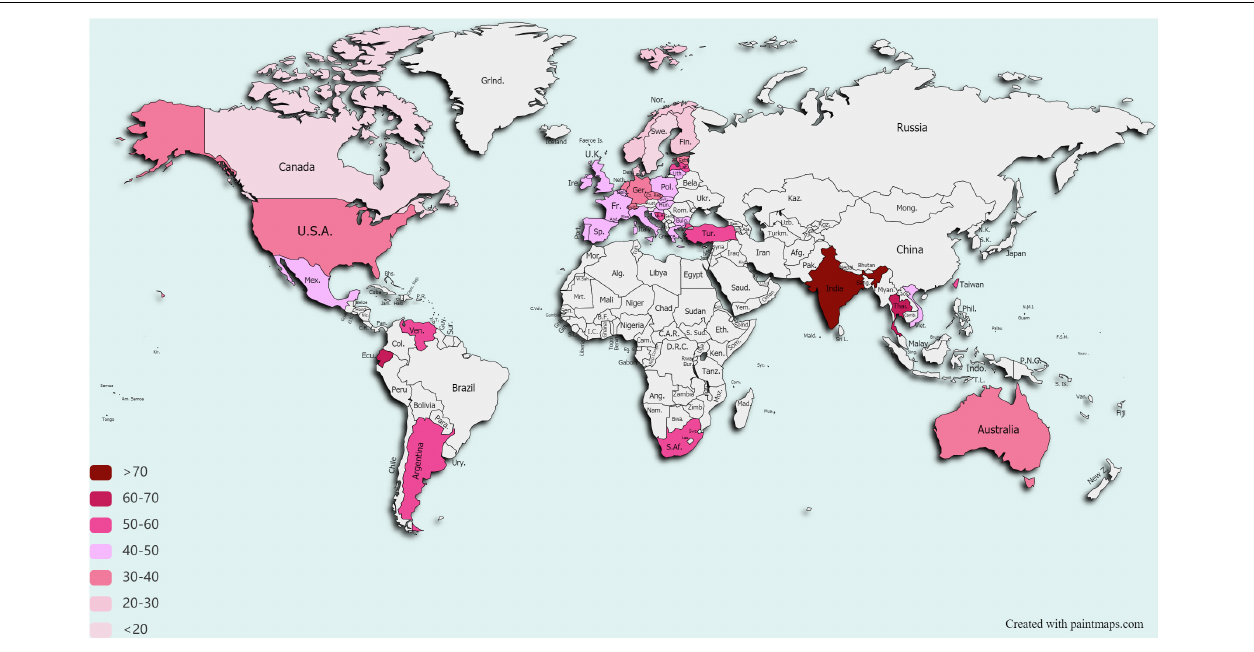
FIGURE 1 | Drug Resistance Index worldwide. Only countries that reported data on antibiotic use for ≥ 5 pathogens and for ≥ 15 pathogen–antibiotic combinations for at least 1 year between 2012 and 2015 are depicted. Data taken from Klein et al. (2019). Data on Taiwan are taken from Resistance Map